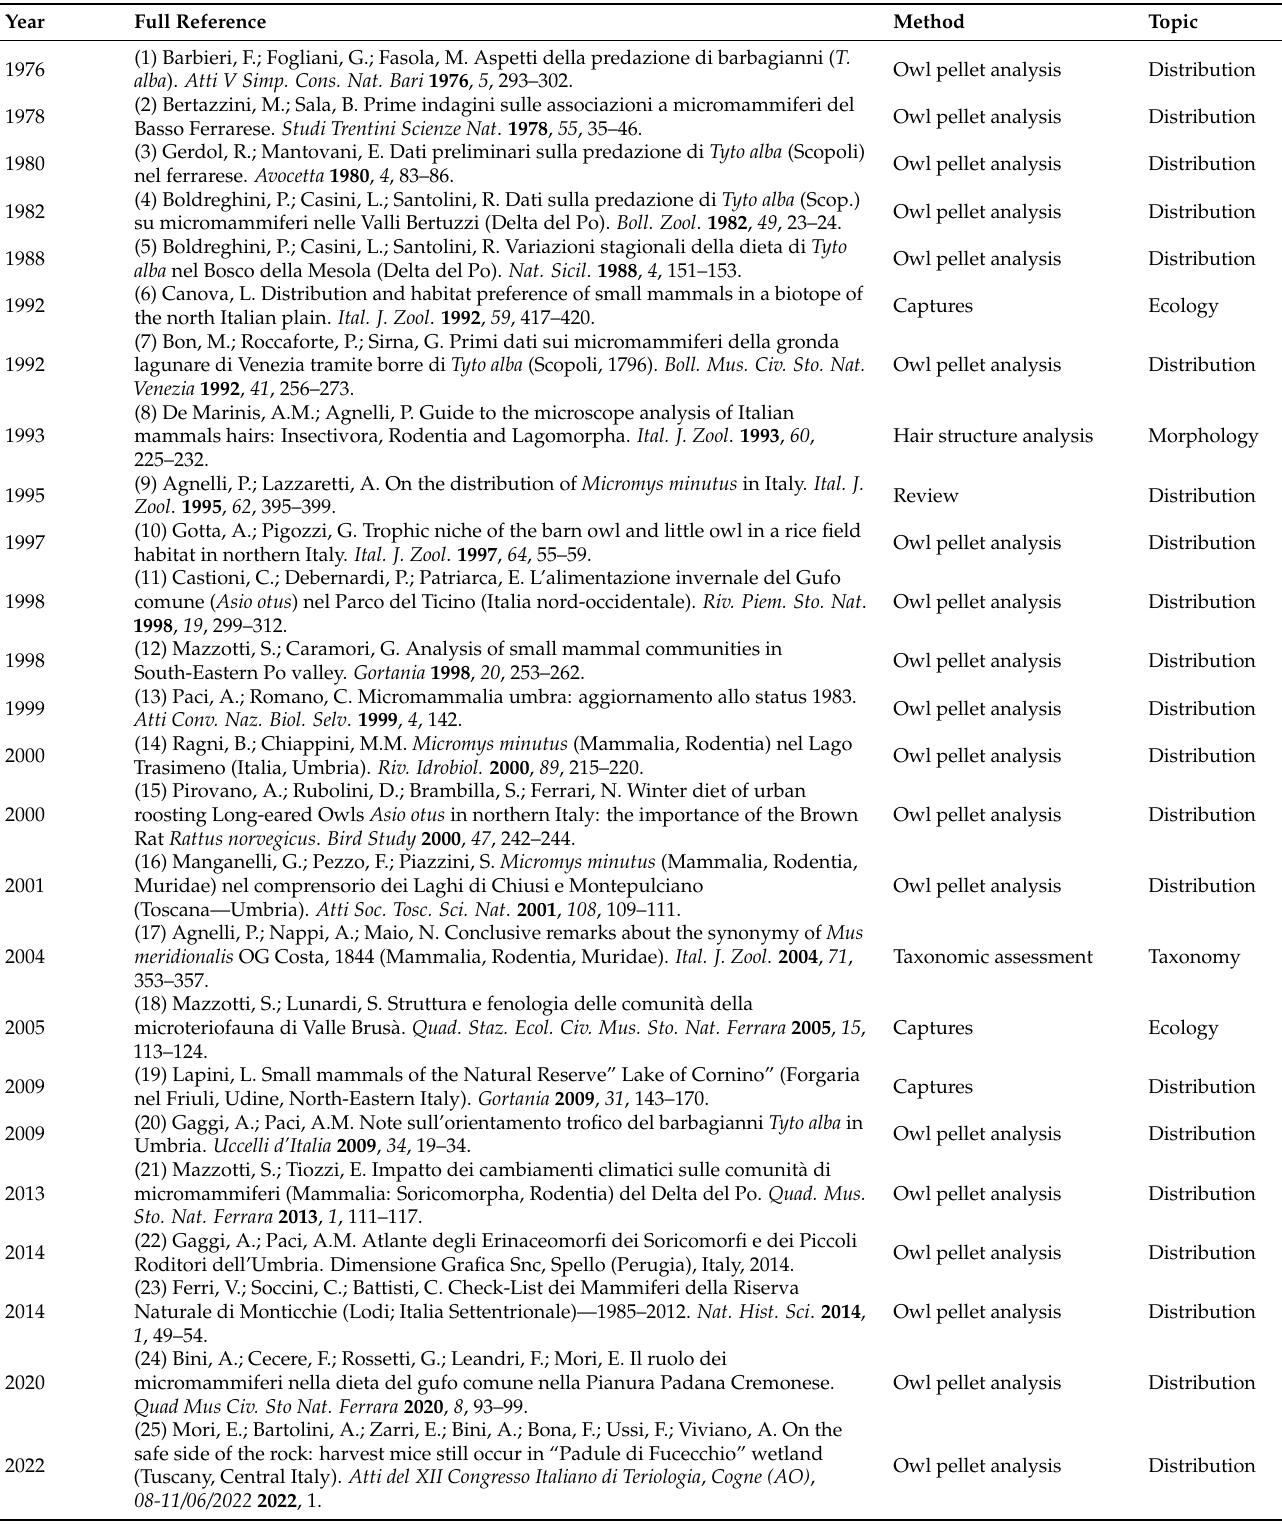
Table A1. List of published works (numbered) in 1976–2022 dealing with harvest mice in